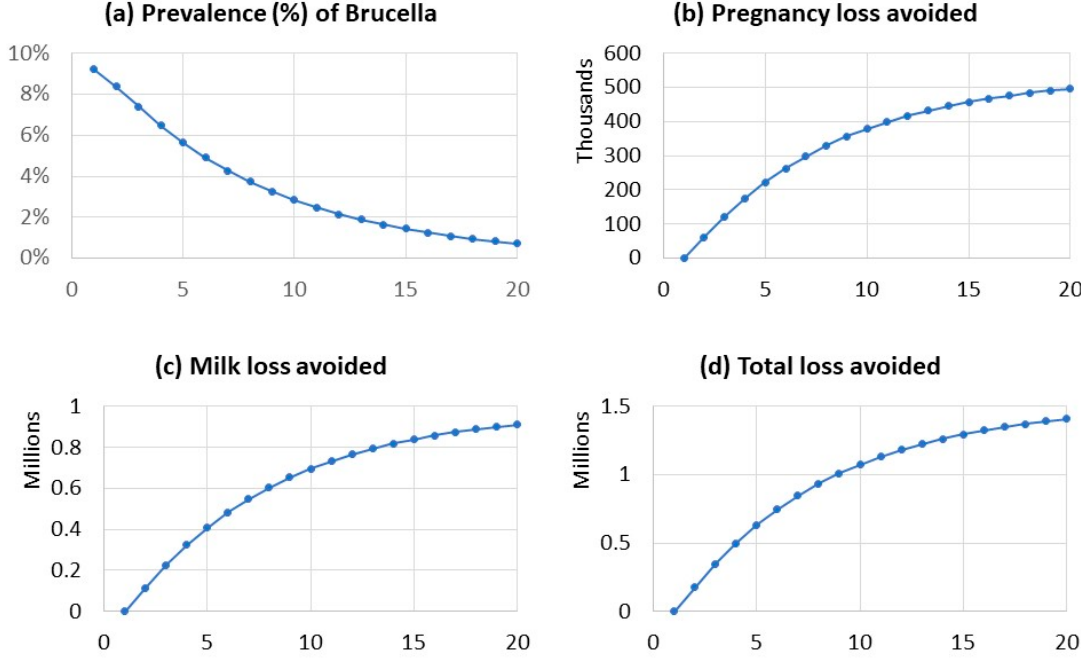
Figure 1. Estimated decline in the prevalence of Brucella ( a ) when implementing a mass vaccination programme over twenty years (horizontal axis). The figure depicts the avoided pregnancy loss ( b ), avoided milk loss ( c ), and the predicted total loss avoided ( d ) over twenty years of application of the proposed mass vaccination.